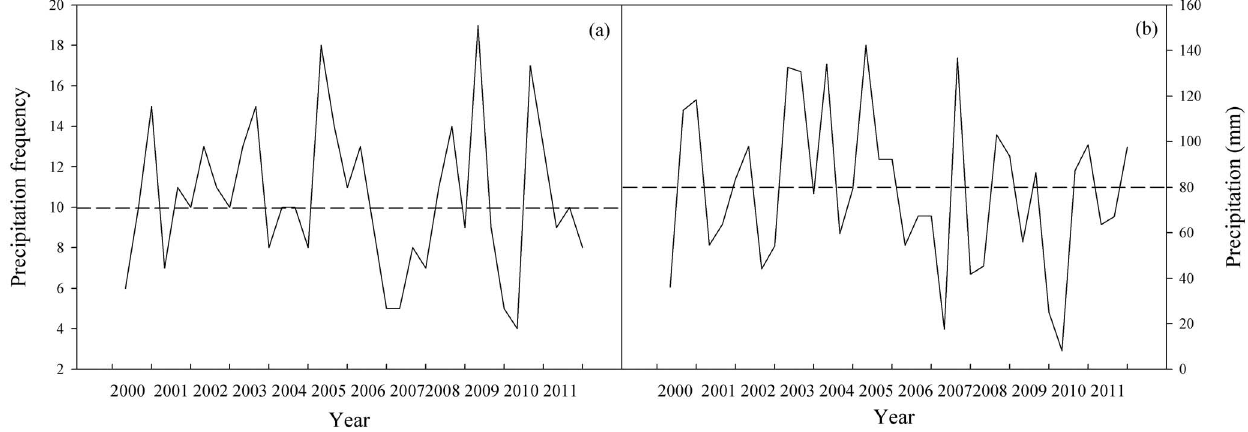
Figure 2. The frequency and amount of rainfall precipitation in summer (Jun-Aug) from 2000 to 2011. The average monthly precipitation was , 80 mm. Data were collected by the Meteorological Bureau of Changling County, China.